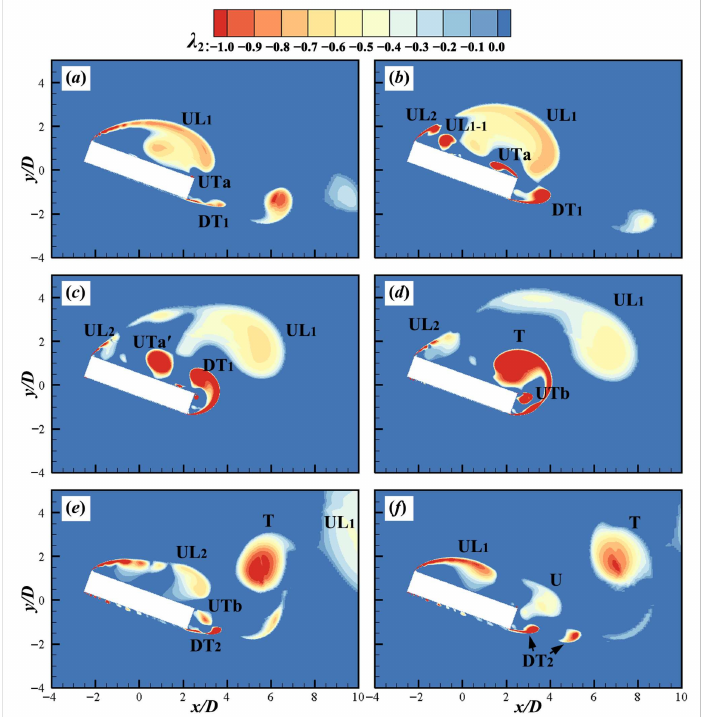
Figure 25. Vortex evolution within a vortex shedding period at α = 20 ◦ . ( a ) tU ∞ /D = 849.0, ( b ) tU ∞ /D = 855.0, ( c ) tU ∞ /D = 859.0, ( d ) tU ∞ /D = 861.0, ( e ) tU ∞ /D = 867.0, ( f ) tU ∞ /D = 871.0.